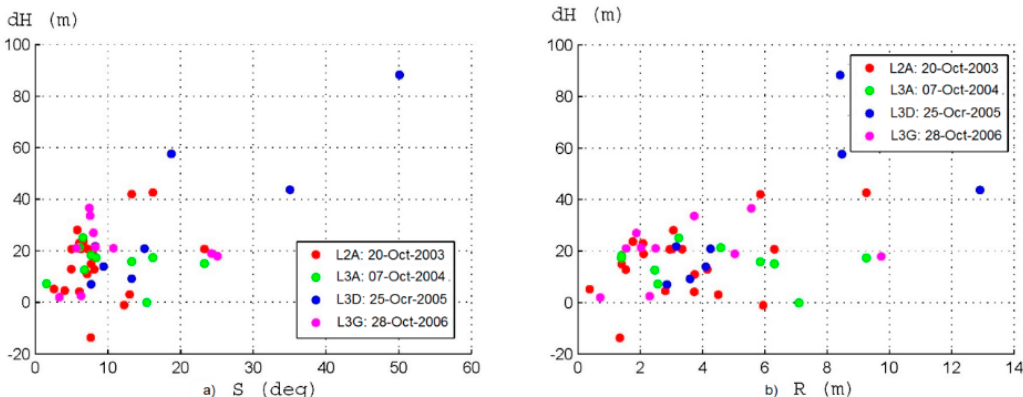
Figure 8. Relations between: ( a ) glacier elevation difference and slope; and ( b ) glacier elevation difference and roughness. Glacier elevation differences are between ICESat campaigns L2A, L3A, L3D and L3G and the SRTM DEM reference surface over a glaciated area (No. 20 in Table S1) at Mount Guala Mandhata I, belonging to the Ganges Basin.